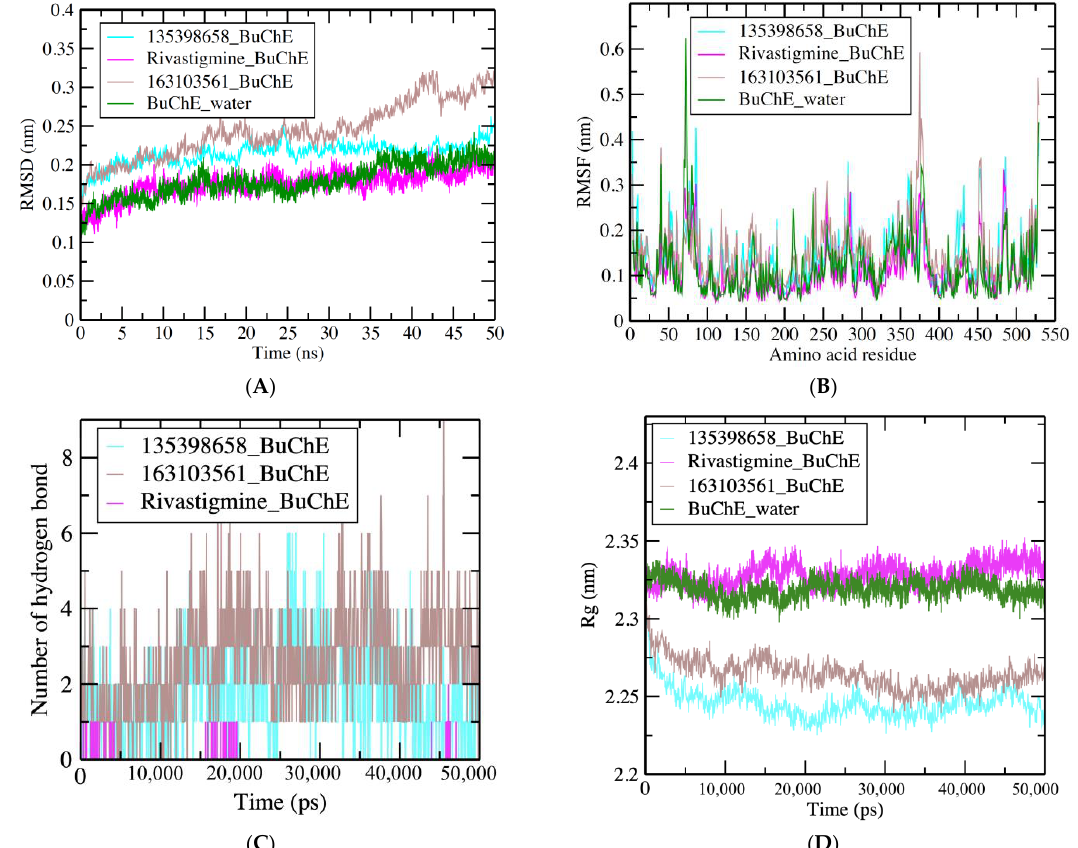
Figure 4. ( A ) RMSD plot of 135398658–BuChE (turquoise), control drug rivastigmine–BuChE (pink), 163103561–BuChE (brown), and BuChE in water (dark green) complexes. ( B ) RMSF values of the enzyme and compound complexes per amino acid residues. ( C ) Number of hydrogen bonds formed between compounds and BuChE in 50,000 ps. ( D ) Rg values that show the compactness of BuChE and compounds complexes maintained for the whole simulation period.